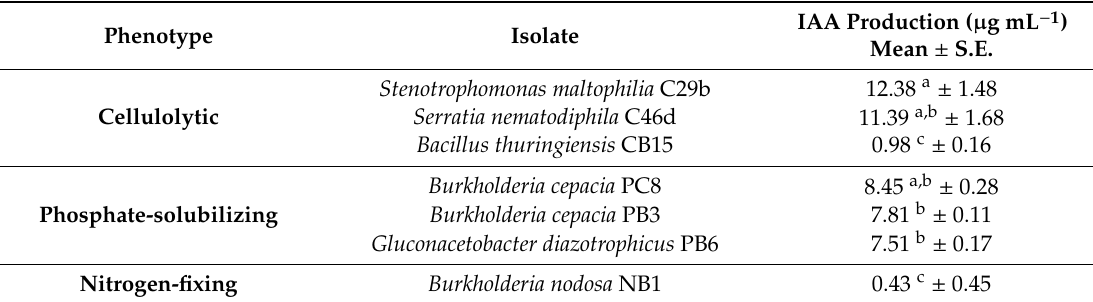
Table 6. Indole-3-acetic acid production by selected functional bacterial